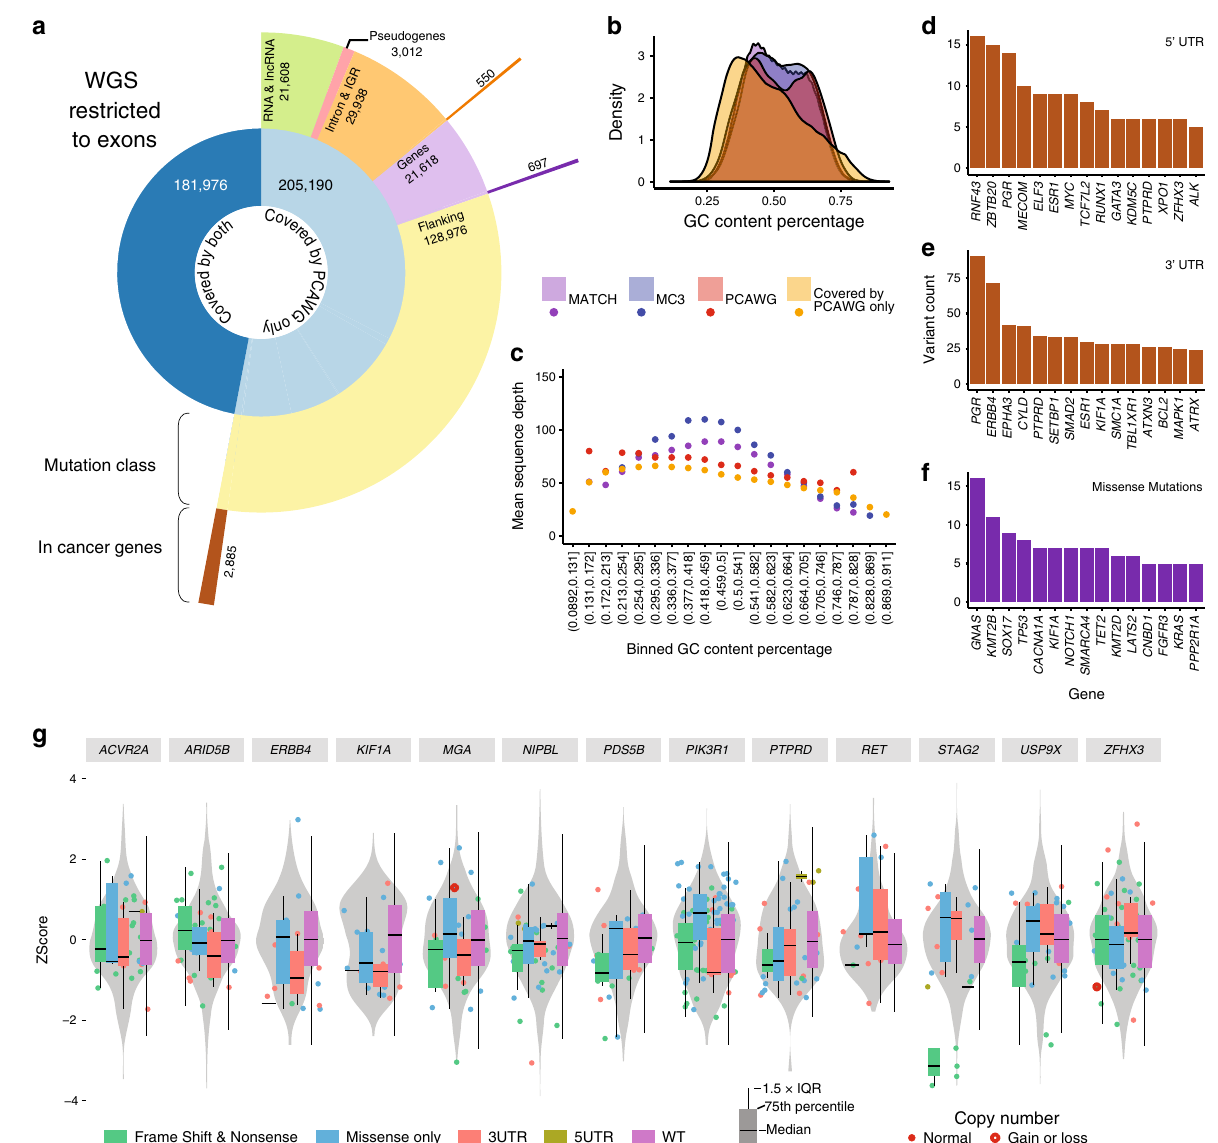
Fig. 5 WGS mutations in exonic regions not captured by WES. a A sunburst diagram provides a breakdown of variants that are removed during the coverage step of the tool. The innermost circle represents the total number of variants identi fi ed upon fi ltering for exome beds used by MC3. Then, we restrict PCAWG variants to well-covered MC3 regions for each sample. The majority of gencode.v19 annotated and the BROAD target bed fi le of exonic regions are suf fi ciently covered by PCAWG in fl anking regions: 3 ’ UTRs, 5 ’ UTR, and 5 ’ Flanking. The outermost ring illustrates the number mutations identi fi ed by PCAWG that were poorly covered by MC3. b A density plot illustrates the density of percent GC-content from a 100 bp window surrounding a variant. Four variant-sets are displayed: matched, private to MC3, private to PCAWG, and we extend our dataset to include exonic variants not covered by WES but suf fi ciently covered in WGS (Covered by PCAWG only). c A scatter plot displays mean sequence depth ( y -axis) by increasing GC-content bins ( x -axis). Points are colored according to variant set (same as panel b ). d – f Total annotated mutations counts from 3 different annotated regions are shown for 5UTR, 3UTR, and missense mutations, respectively. g Expression Z − Scores for 3 ’ UTR using all TCGA-UCEC samples. Cis -RNAseq expression violin plots are displayed for 13 genes. On top of the gene-level distribution violin plot, box and whisker plots display sample expression based on mutation classi fi cation (box include 25th quantile to 75th quantiles, and whiskers extend to 1.5 times the interquartile